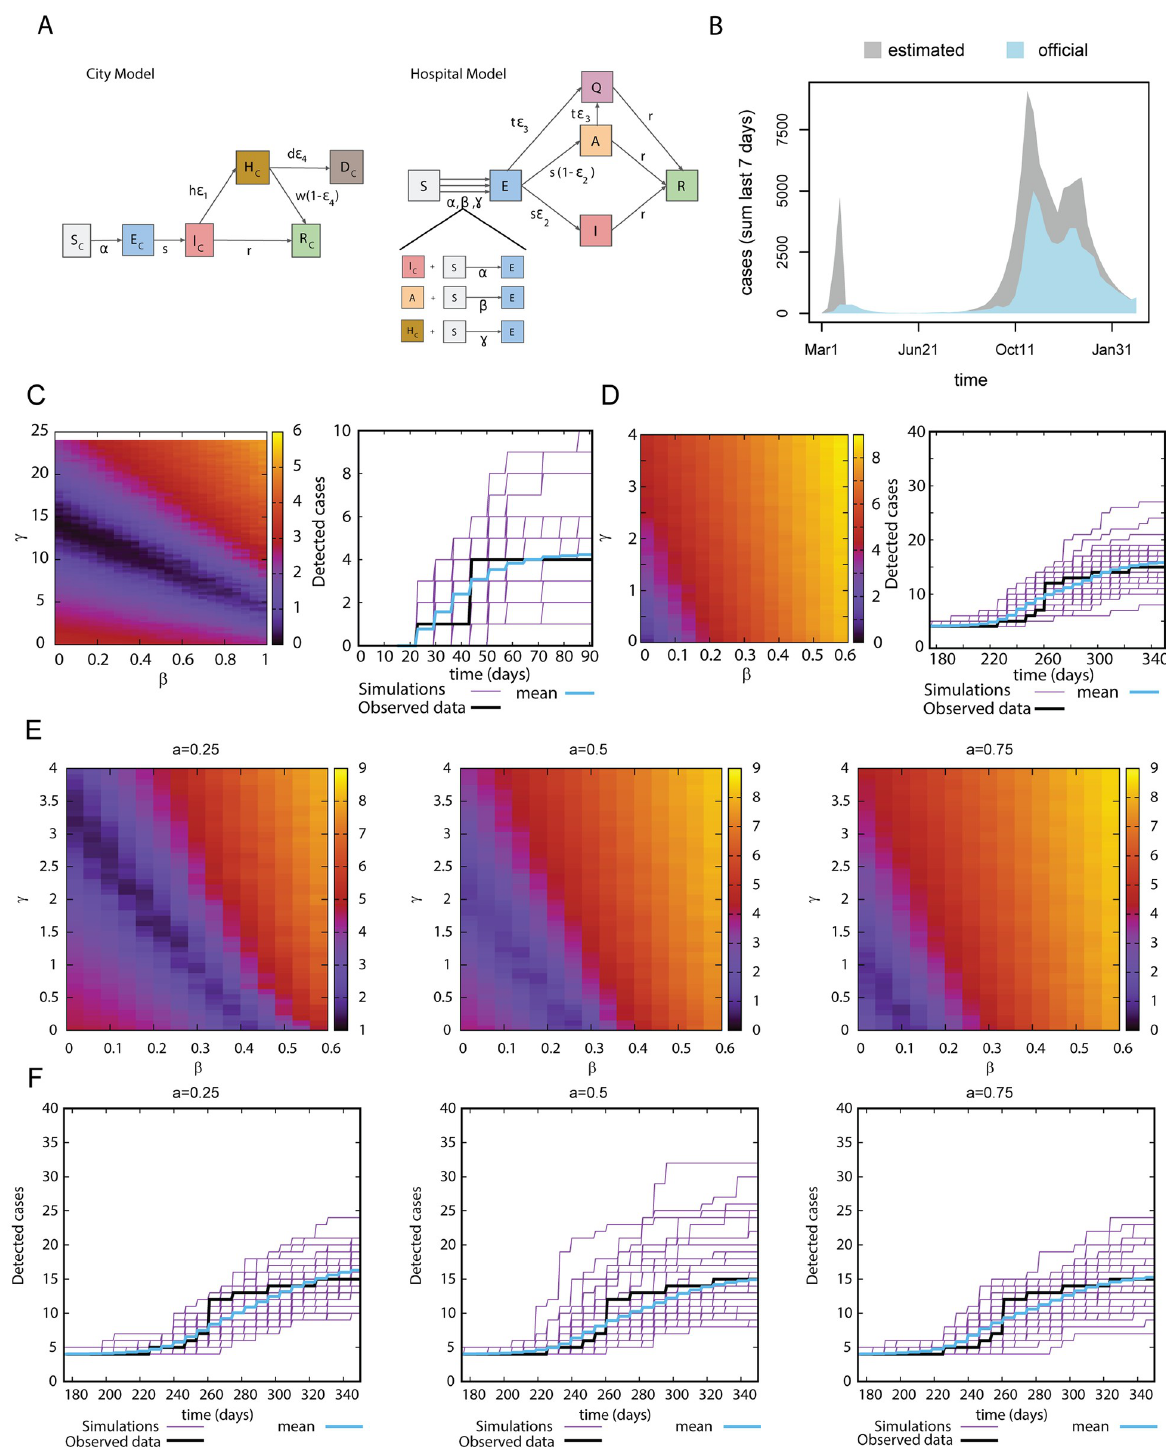
Fig 2. Model calibration and integration of test results. (A) Sketch of the multi-scale epidemiological model accounting for the dynamics in the city and in the hospital. (B) Number of official cases in the canton of Bern compared with the predicted new cases shown by our model. (C) left panel: Error function (see Methods) of the fit for wave 1, right panel: Observed (black curves) and simulated (50 Gillespie simulations, purple curves), and average of 1000 simulations of the 1st wave (blue curves). γ = 14.72, β = 0, a = 1 (D) Error function of the fit for second wave displayed as in (C). γ = 0, β = 0, a = 1. (E) Error function of the fit for second wave for different values of a . (F) Observed and simulated (50 Gillespie